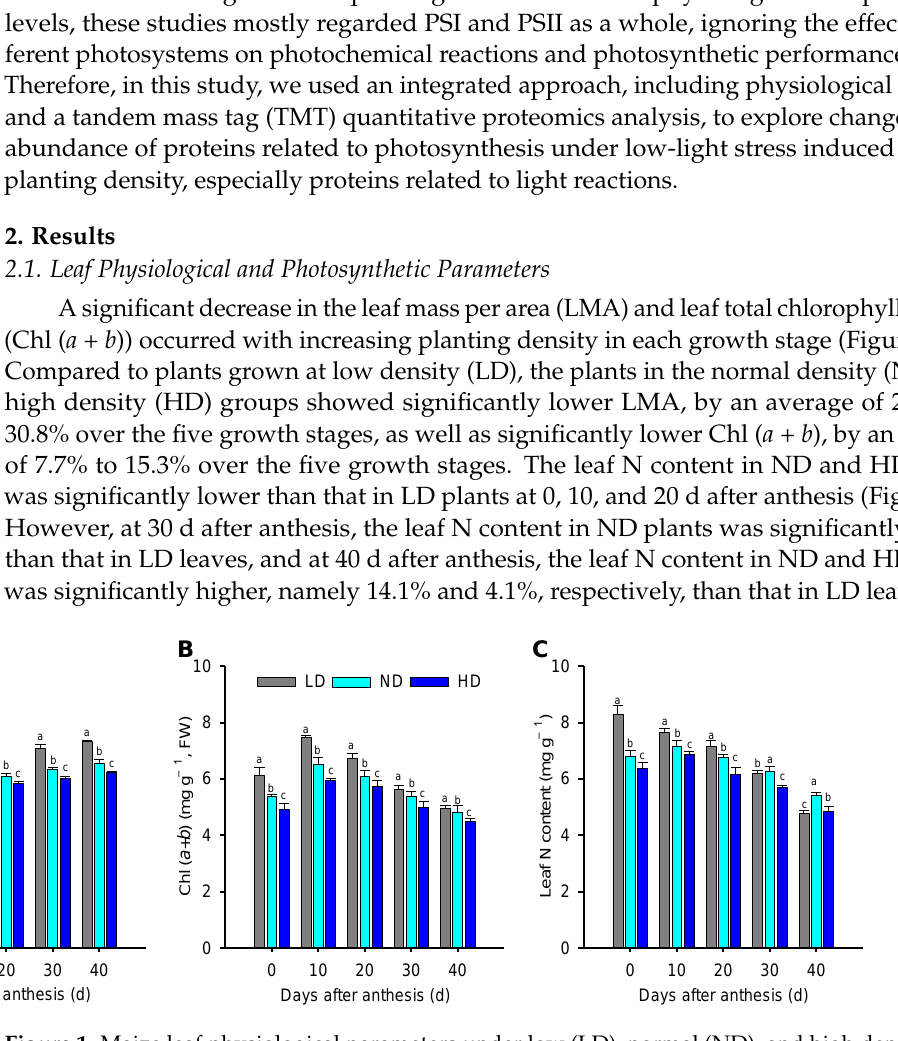
Figure 1. Maize leaf physiological parameters under low (LD), normal (ND), and high density (HD) planting at 0, 10, 20, 30, and 40 d after anthesis. ( A ) Leaf dry mass per area (LMA), ( B ) leaf total chlorophyll content (Chl ( a + b )) and ( C ) leaf nitrogen content. Means ± SD, n = 5. Different lowercase letters (a, b, c) denote statistical differences by LSD test ( p ≤ 0.05) between different